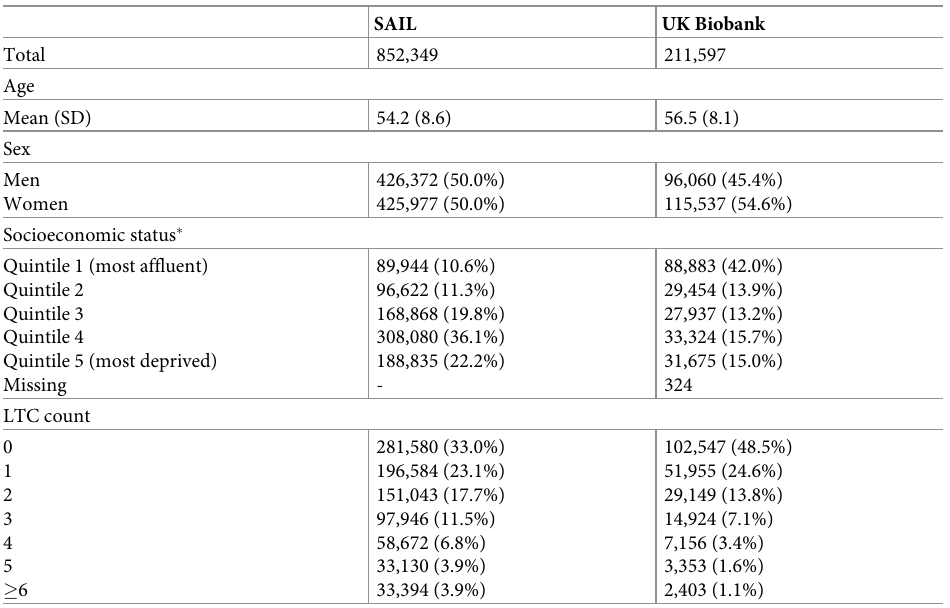
Table 1. Baseline demographic